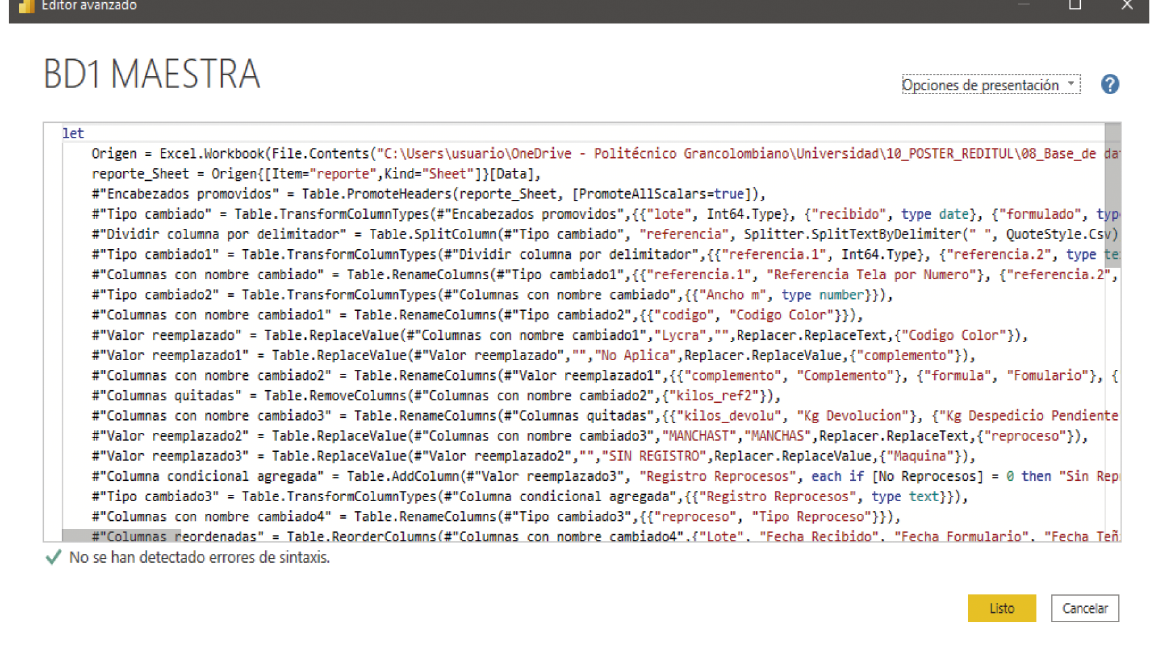
Figure 4. Database editing example in Power